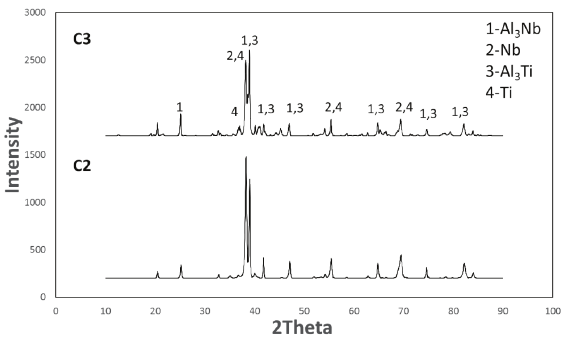
Figure 8: XRD Analyses of C2 and C3 sample.